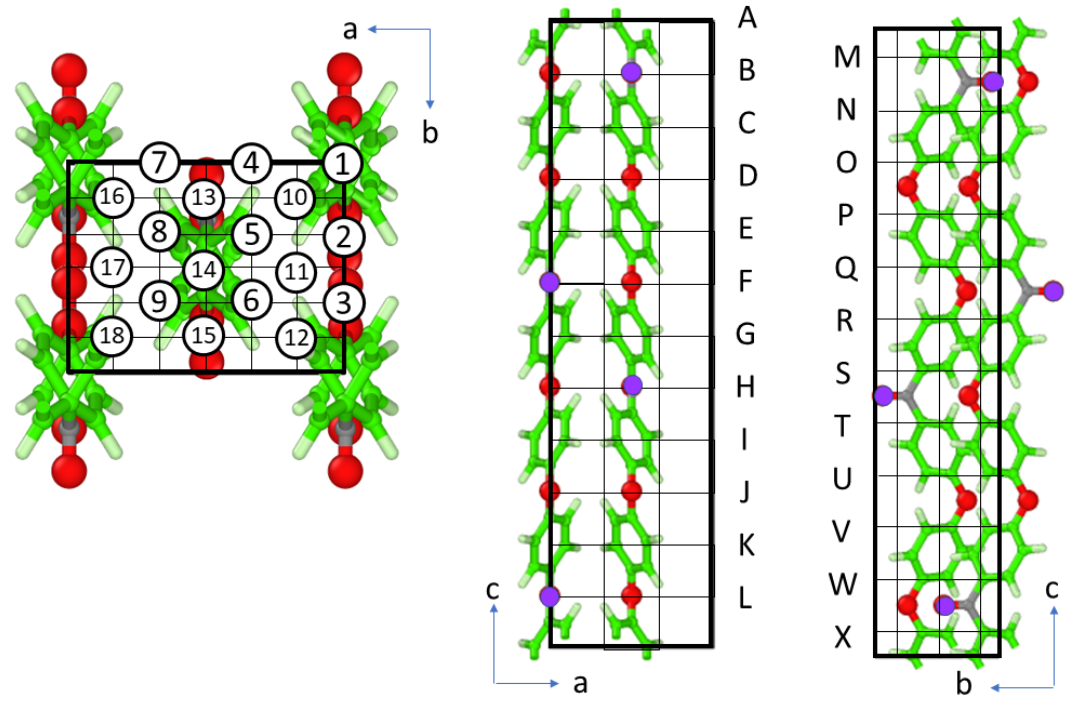
Figure 6. Unit cell of PEEK polymer and notation of the calculated points. a , b , and c are unit cell directions. 1 (cid:13) ~ 9 (cid:13) ( 10 (cid:13) ~ 18 (cid:13) ) in ab plane were coupled with A~L (M~X) in the c direction. A point is denoted with a circled number and an uppercase letter in the figure. Aromatic carbons are green, hydrogens are white, ether oxygens are red, and ketone carbons and oxygens are shown in purple.